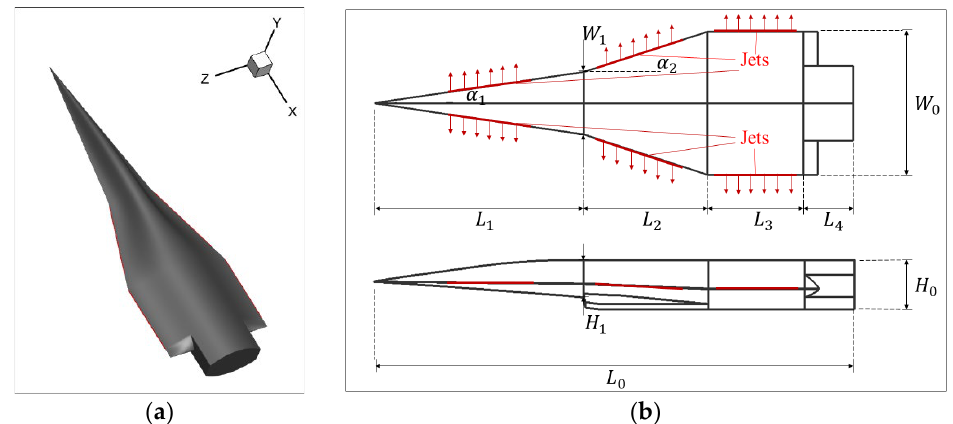
Figure 1. The baseline geometry. ( a ) Three-dimensional view; ( b ) Top and side views.